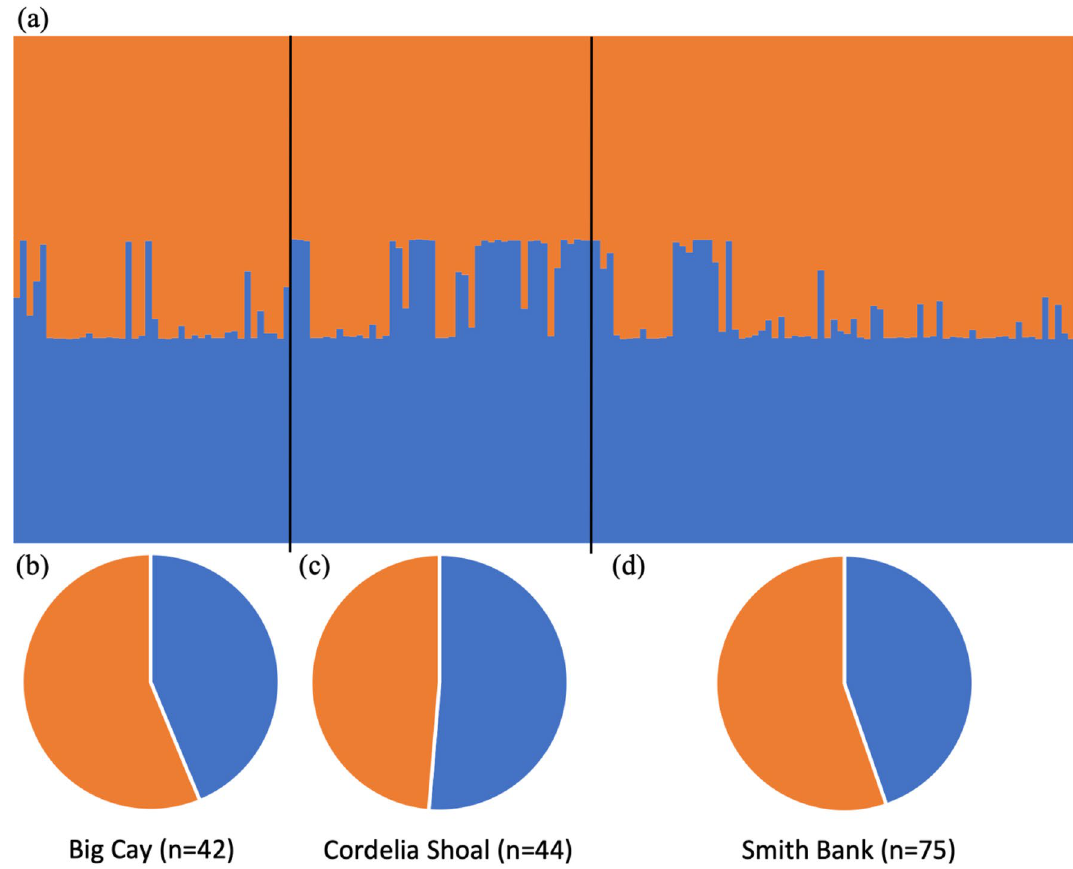
Figure 3. STRU CTU RE outputs for all genotypes (K = 2), mean of 10 permutations, for each colony within each of the banks ( a ); and the mean cluster classifications of all colonies within Big Cay ( b ); Cordelia Shoal ( c ); and Smith Bank ( d ). Blue—Cluster 1; and Orange—Cluster